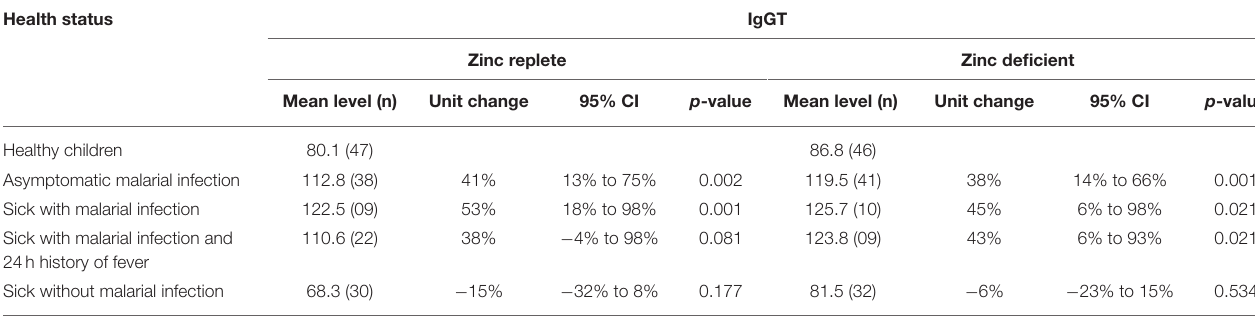
TABLE 2 | Variation in plasma IgGT levels in different health situations associated with malarial infection in zinc-replete